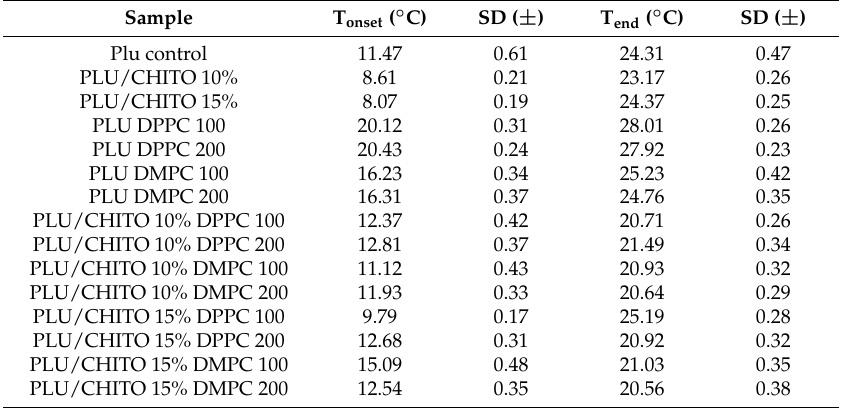
Table 2. Micellation process. Transition temperatures for the different hydrogels